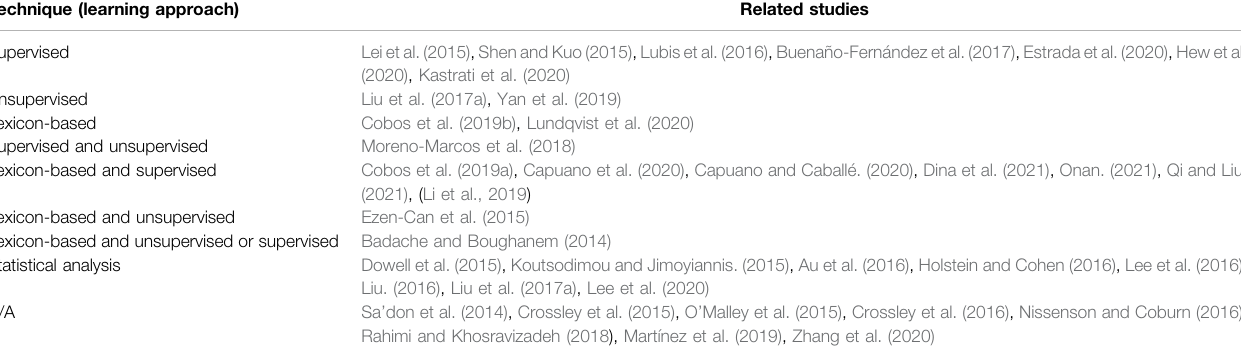
TABLE 3 | Papers based on used technique/learning approach.